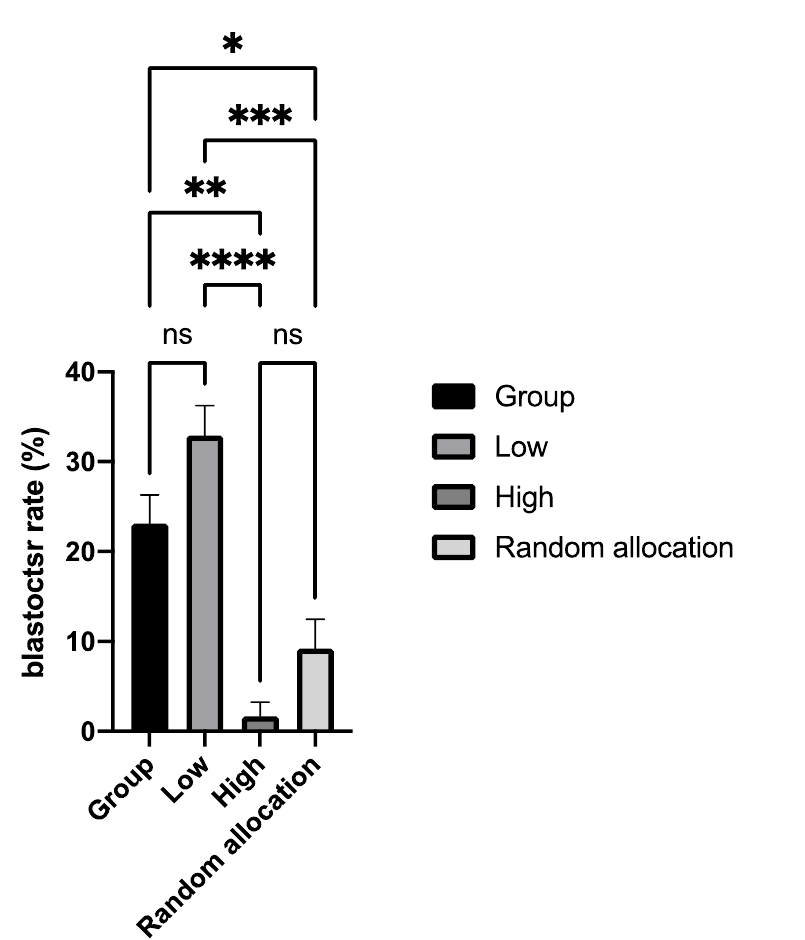
Figure 1. Bovine embryos that have a “lower” overall amino acid turnover produce significantly more blastocysts than to embryos with a “high” overall amino acid turnover. In order to complete this experiment, bovine embryos were cultured individually for 36h and prospectively allocated to a group based on whether their amino acid turnover was “high” or “low”. Two control groups were used; one where embryos were allocated randomly to groups after 36h individual culture and a second where embryos were maintained in group culture for the duration of the experiment. Stars indicate significant differences between groups (* p < 0.05; ** p < 0.01; *** p < 0.001; **** p < 0.0001). Redrawn from Sturmey et al [123].